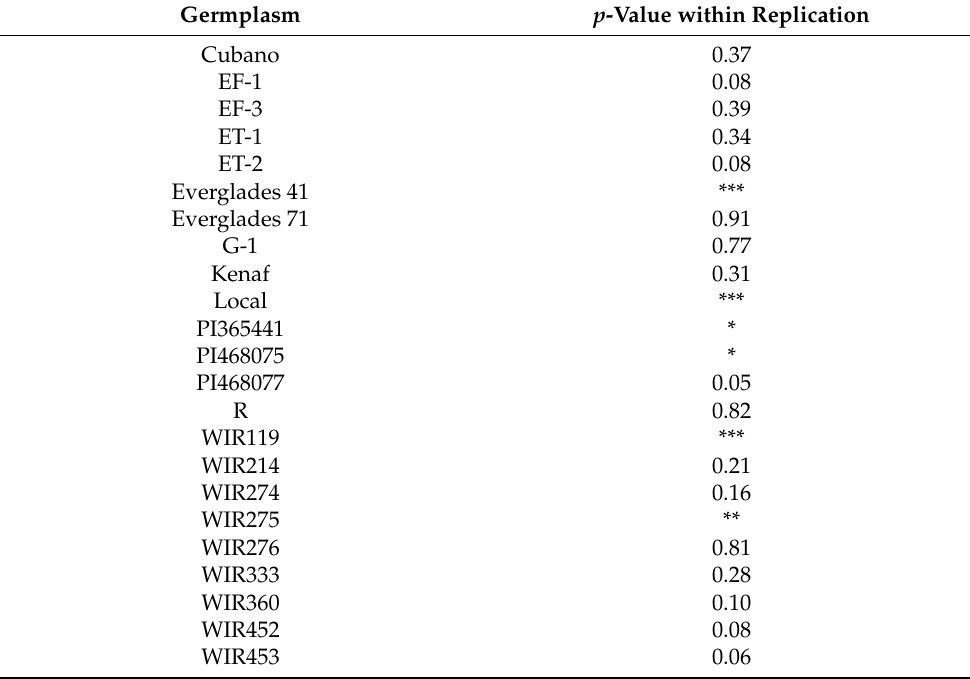
Table 1. The results of the Kruskal–Wallis